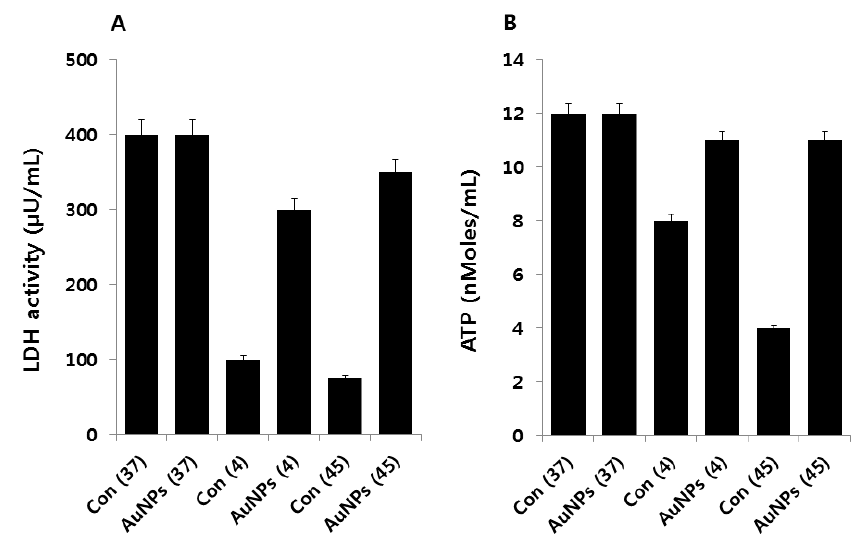
Figure 5. Effect of AuNPs on LDH activity and ATP levels. ( A ) E. coli cells were pre-incubated with AuNPs (1 μ g/mL) for 1 h, stressed at 4 °C or 45 °C, and subsequently recovered for 12 h at 37 °C. LDH activity was determined by measuring the reduction of NAD + to NADH and H + during the oxidation of lactate to pyruvate. Data are shown as means and standard deviations calculated from three independent experiments. AuNP-treated groups showed statistically significant differences from the control group by Student’s t -test ( p < 0.05); ( B ) E. coli cells were pre-incubated with AuNPs (1 μ g/mL) for 1 h, stressed at 4 °C or 45 °C, and subsequently recovered for 12 h at 37 °C. The ATP level was determined by measuring luminescence levels and comparing them to an ATP standard curve. Data are shown as means and standard deviations calculated from three independent experiments.